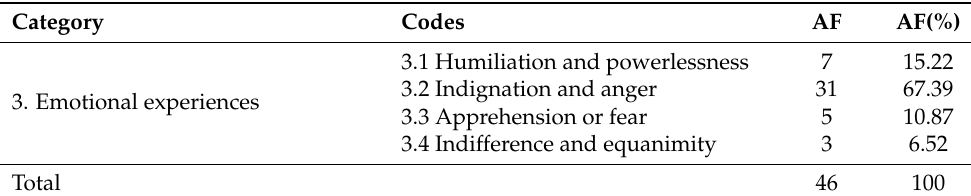
Table 3. Frequencies emerging from the narratives coded under Category